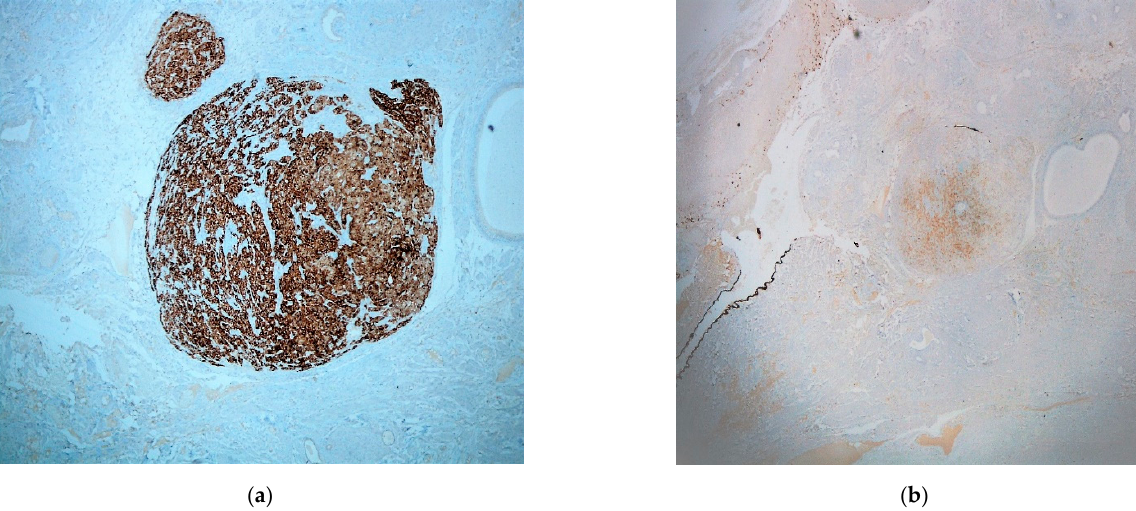
Figure 3. Immunohistochemistry: ( a ) Melan-A (MART1) (×40); ( b ) calretinin (×20) (mesothelial cells of the fallopian serosa serve as the internal positive control).